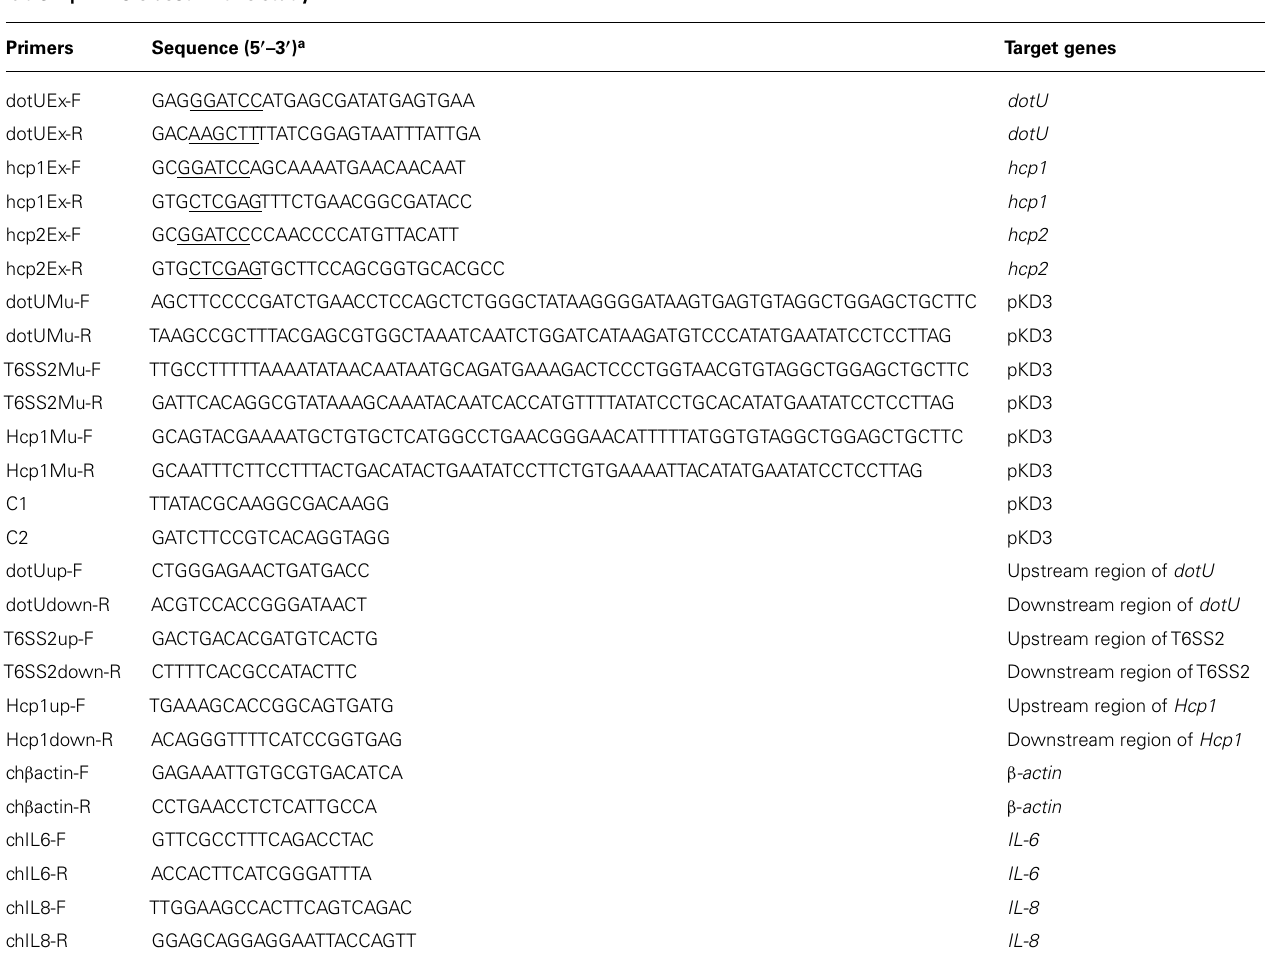
Table 2 | Primers used in this study.